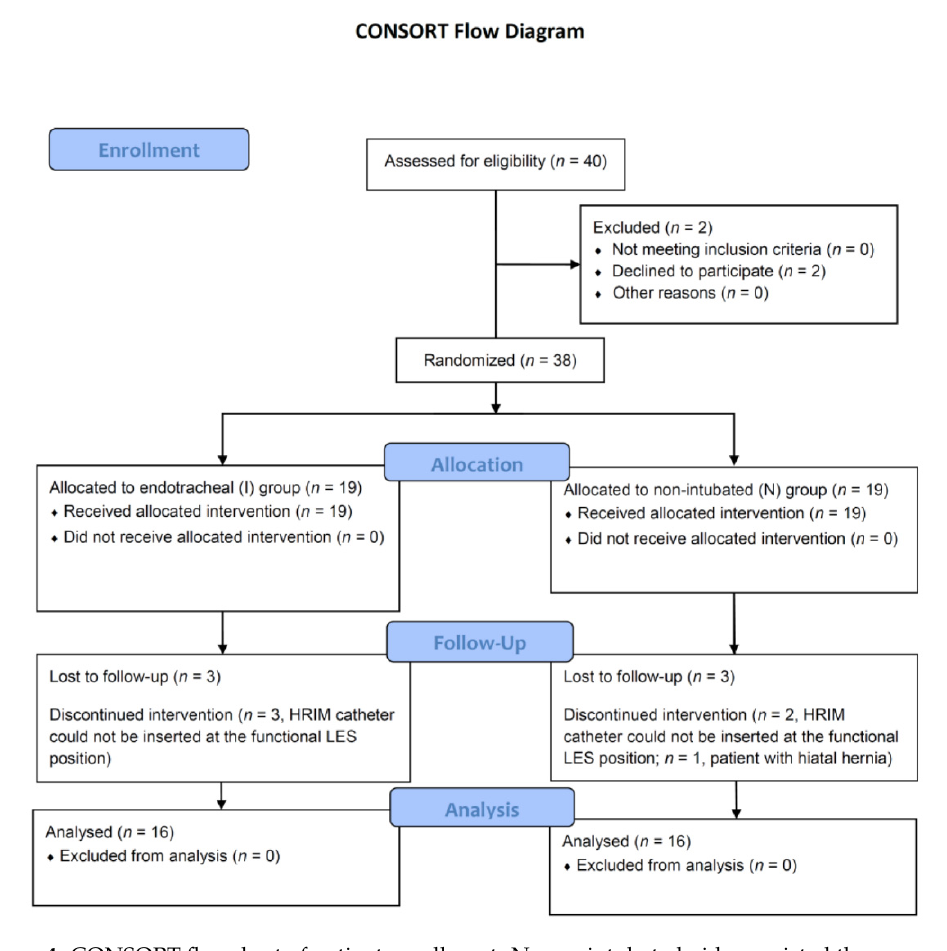
Figure 4. CONSORT flowchart of patient enrollment. N: non-intubated video-assisted thoracoscopic surgery group; I: intubated video-assisted thoracoscopic surgery group; LES: lower esophageal sphincter; HRIM: high-resolution impedance manometry.